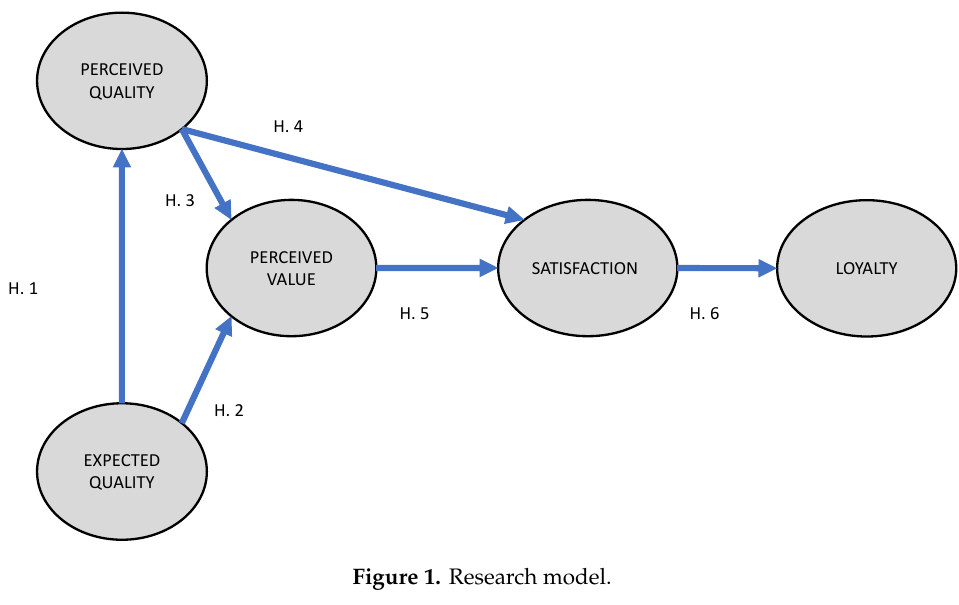
Figure 1. Research model.